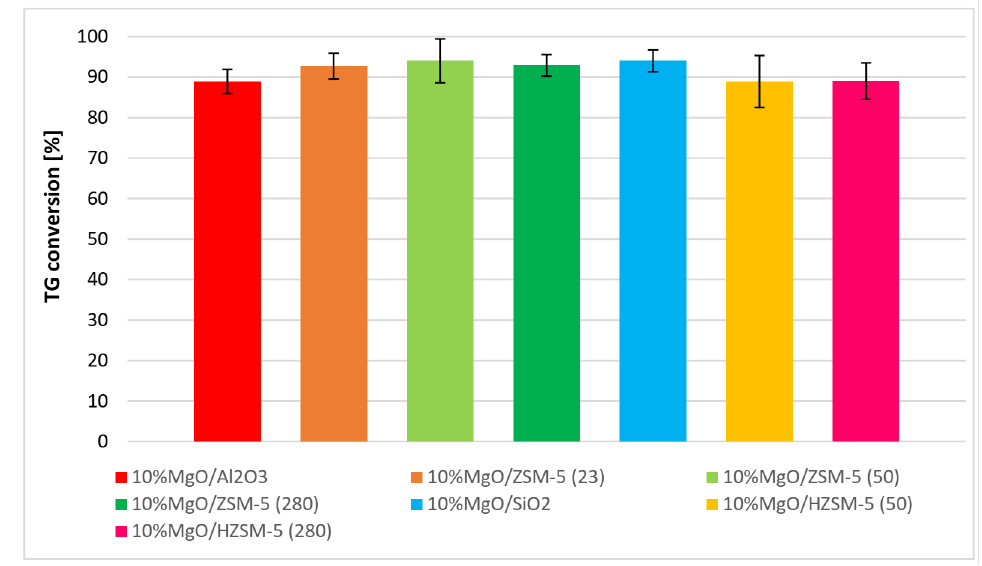
Figure 1. TG conversion obtained for the investigated MgO based catalysts. The ratio of silicon to aluminum is given in parentheses.